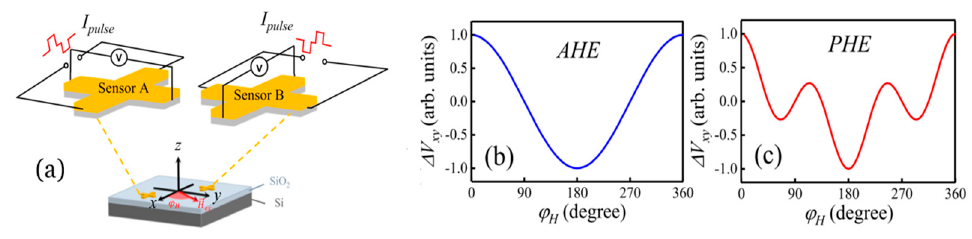
Figure 11. ( a ) Angular sensor composed of two identical Hall crosses orthogonally placed on the same substrate to allow 2D measurement of the magnetic field. In order to get an accurate result, the extraordinary ( b ) and planar ( c ) Hall contributions have to be separated. Reprinted with permission from ref. [79] 2018 AOP.